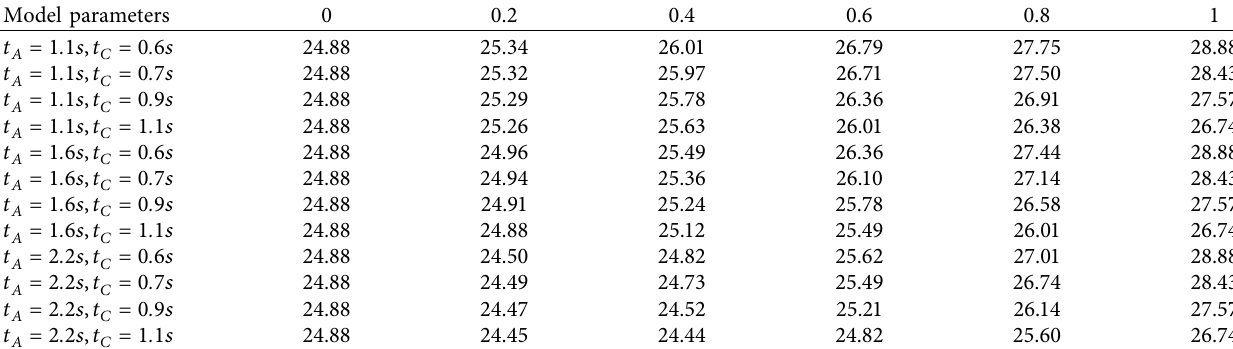
Table 5: Maximum value of v under different model parameters (unit: m/s).